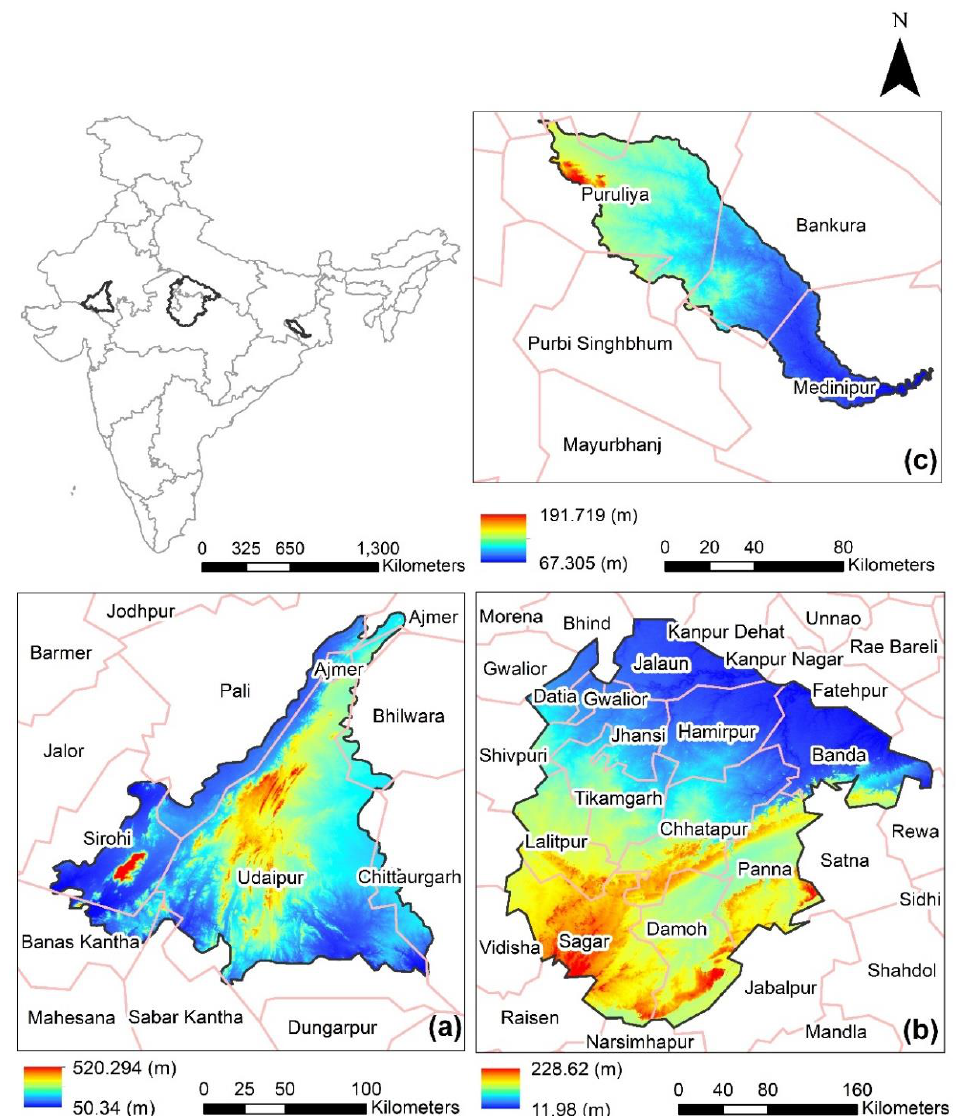
Figure 1. Elevation map of the study areas. ( a ) Araveli Region ( b ) Bundelkhand Region ( c ) Kansabati River Basin. The scale bar represents the elevation in meters.